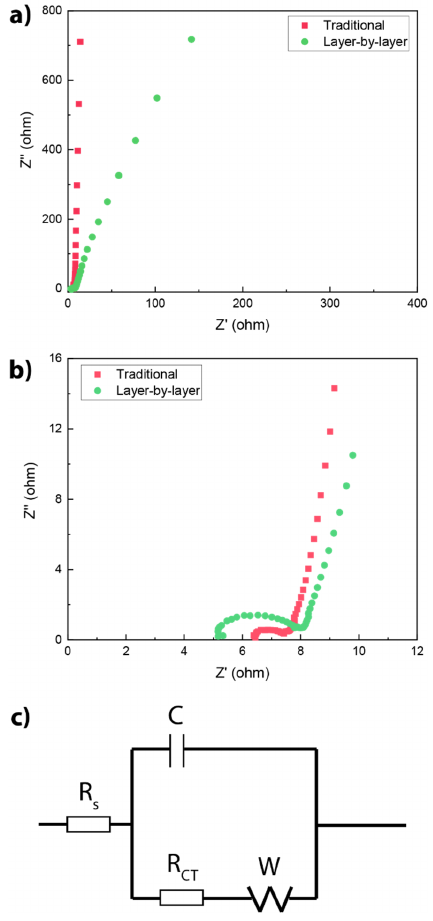
Figure 5. Electrochemical impedance spectra of SCs composed of Per-TAPB-PPI -based electrodes prepared via a conventional mixing or a layer-by-layer method. ( a ) Focused on the lower frequency measurements. ( b ) Focused on higher frequency measurements. ( c ) The equivalent circuit modelling of the EIS spectra.